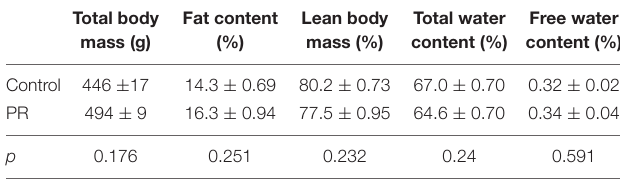
TABLE 2 | Body composition of the adult (12 week-old) experimental animals. Total body mass